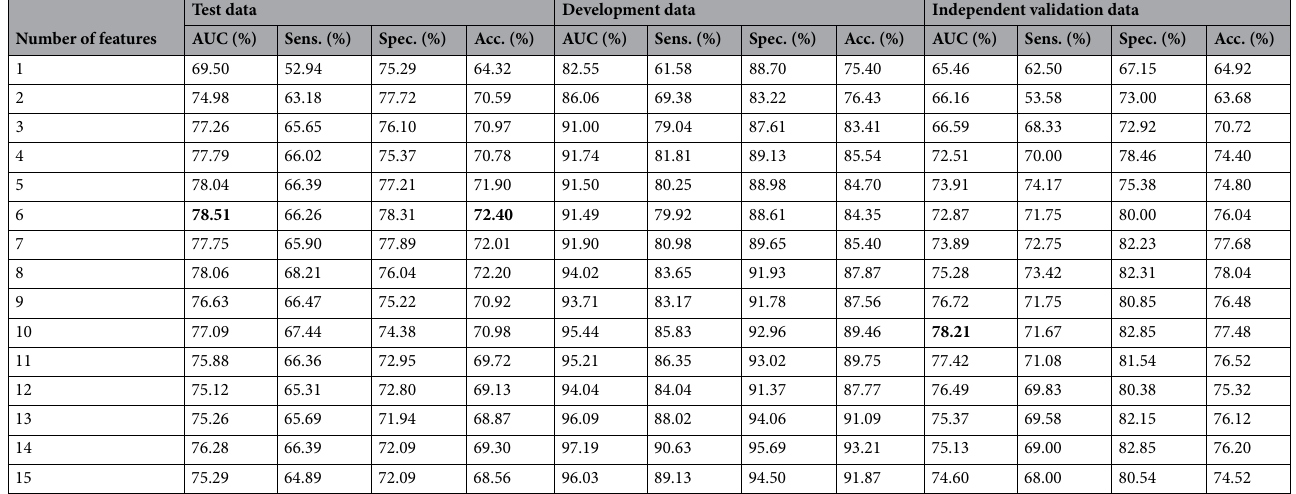
Table 3. Classification results per group. AUC area under the curve (receiver operator characteristics, Sens. Sensitivity, Spec. specificity, Acc. accuracy. Significance values are in bold.